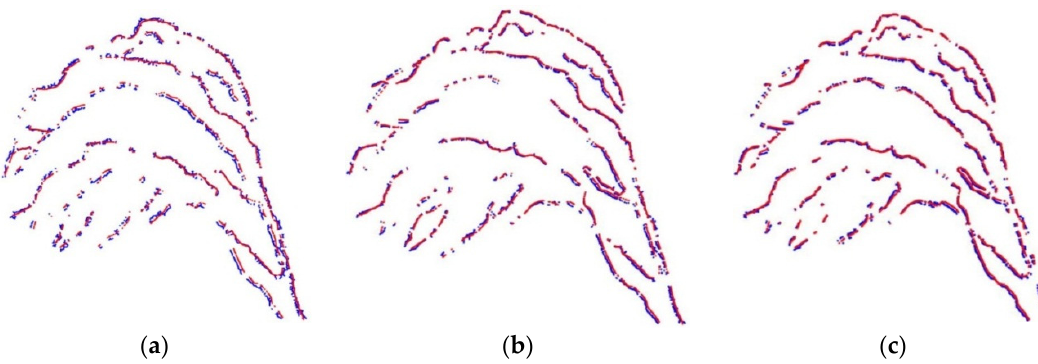
Figure 27. The average distance (RMSE) between the ground truth (red segments) and the extracted landslide scarp data (blue segments); Scarp segments extracted using ( a ) Eigenvalues ratios; ( b ) topographic surface slopes; and ( c ) topographic surface roughness index